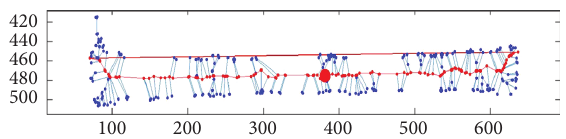
Figure 7: Straight skeleton of region, center of region, and shortest path over the straight